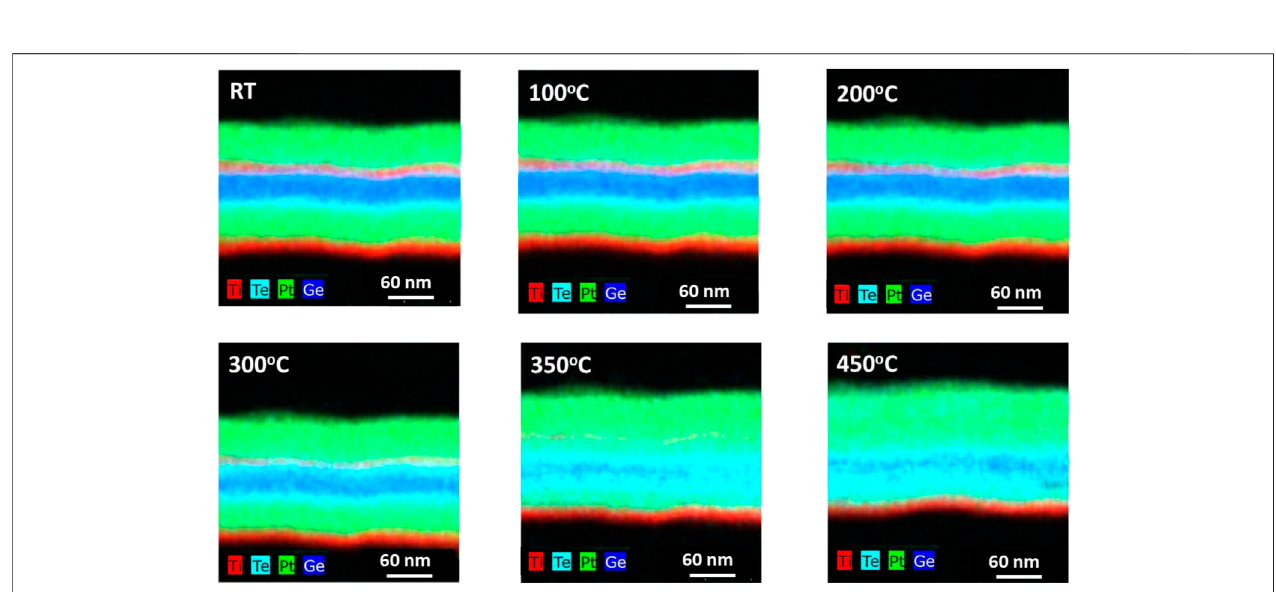
FIGURE 8 | Elemental Line pro fi les from the XEDS maps of the device structure (A) in the preformed condition and (B) after heating to 200 ° C.